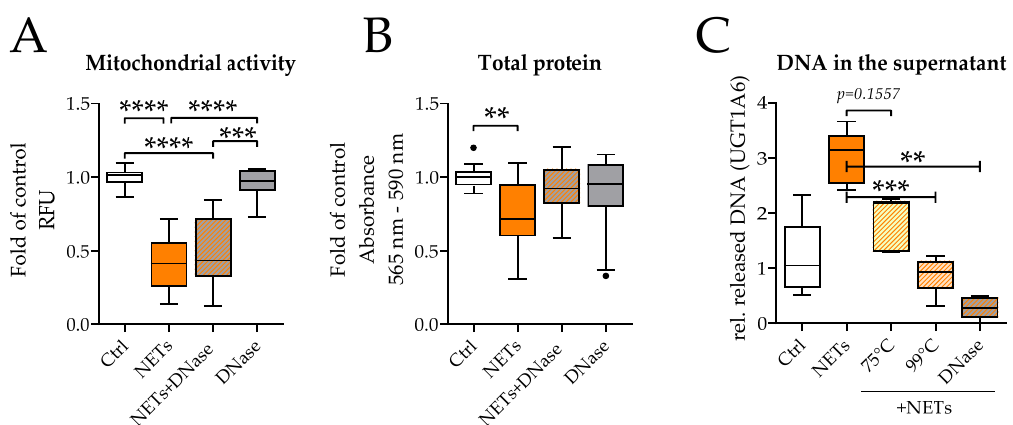
Figure 4. DNase did not prevent NETs toxicity. SCP-1 cells were incubated with NETs and DNase for 48 h. ( A ) Mitochondrial activity was determined by Resazurin conversion. ( B ) Total protein con- tent was determined by SRB staining. ( C ) Effectiveness of DNA removal was analyzed by PCR. N = 3, n = 3. ** p < 0.01, *** p < 0.001, **** p < 0.0001, as determined by the Kruskal-Wallis test. Enzymes and antimicrobial peptides are the other major effectors of released NETs. The DNA content of the NETs directly correlated with the protein content (Figure 5E). Therefore, SCP-1 cells were incubated together with NETs and proteinase K or different protease inhibitors (Leupeptin/Pepstatin A) to inhibit or destroy those effectors. The ad- dition of proteinase K did not restore mitochondrial activity or total protein content (Fig- ure 5A,B). Similarly, incubation with Leupeptin and Pepstatin A did not prevent toxicity of added NETs in SCP-1 cells (Figure 5C,D). Histones are another major component of NETs. Histone antibody treatment or the addition of heparin as a binding competitor for histones both showed no effect on NETs toxicity (Figure 5F–H).